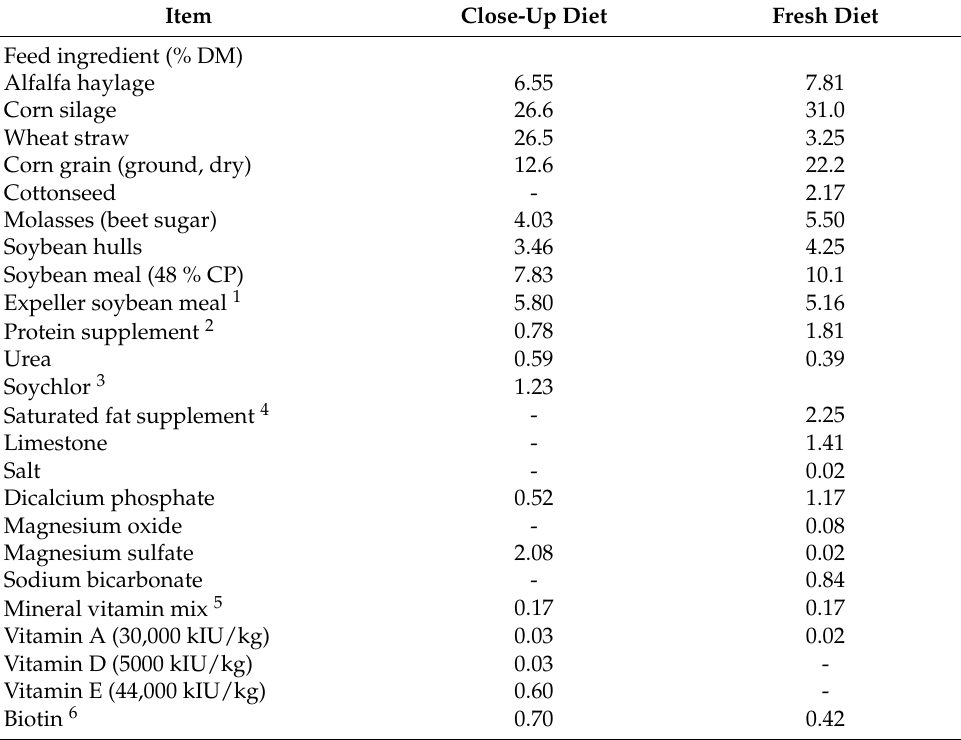
Table 1. Ingredient and nutrient composition of close-up (from − 28 d to parturition) and early lactation (from 1 to 60 DIM)